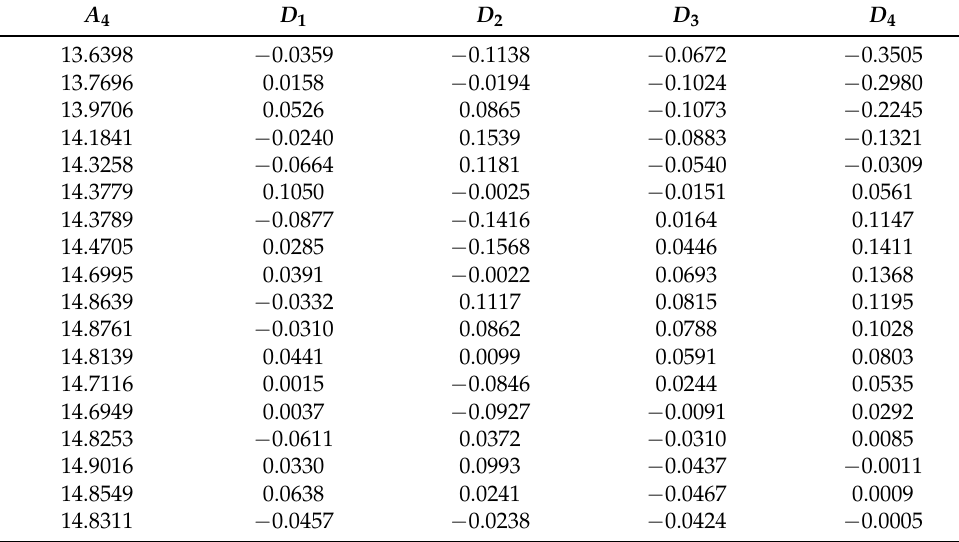
Table 2. Four-level wavelet decomposition of V 1